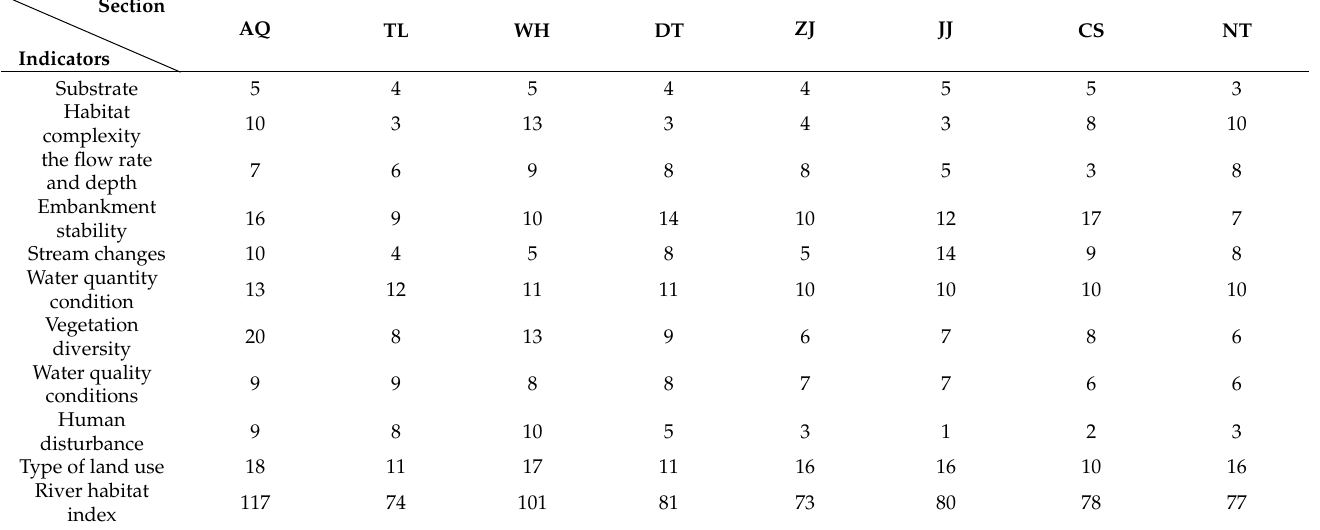
Table 5. Habitat quality assessment in the lower Yangtze